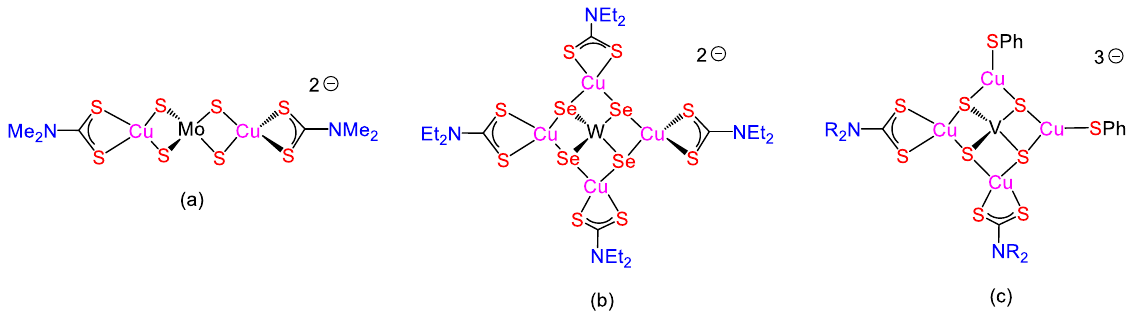
Figure 22. Line drawings of heteronuclear clusters ( a ) – ( c ) formed upon addition of [ME 4 ] 2 − (M = Mo, W; E = S, Se) to CuX in the presence of dithiocarbamate and thiolate ligands.